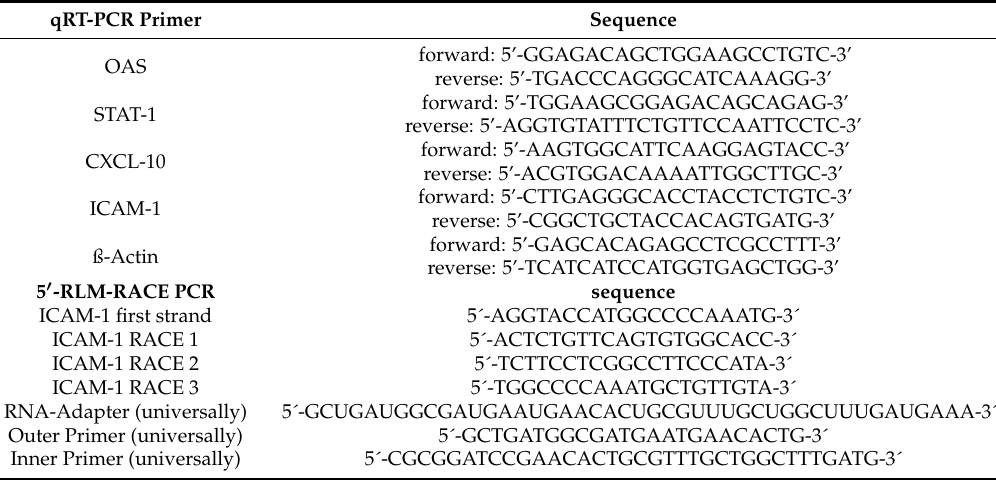
Table 2. Primer sequences for qRT-PCR and primer sequences for 5 (cid:48) -RLM-RACE PCR purchased from MWG Operon (Ebersberg,